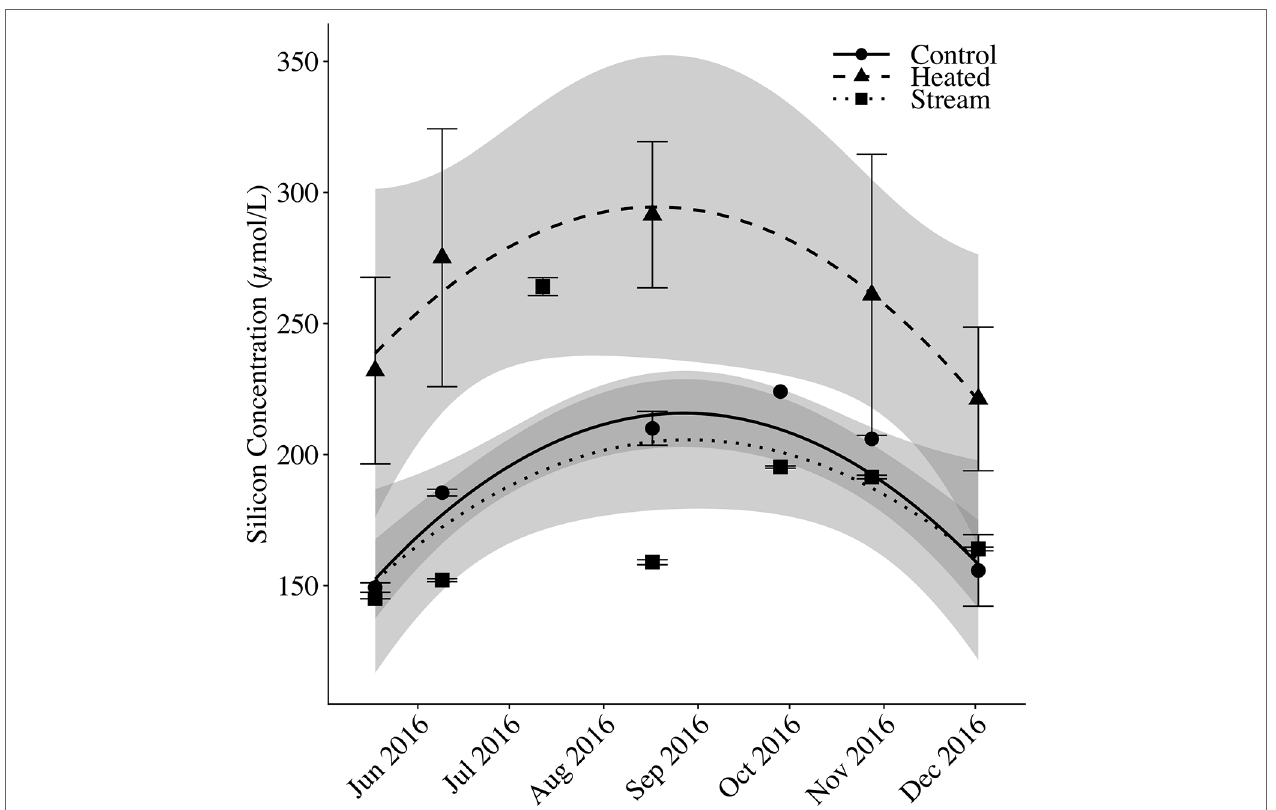
FIGURE 6 | Soil solution and streamwater silicon over time. Mean silicon concentrations (μmol Si/L) are shown for control plot soil solution, heated plot soil solution, and stream water. For soil solution, silicon concentrations are measured as dissolved silica (DSi) only. For stream water, silicon concentration was measured as DSi plus suspended BSi to account for in-stream biological Si uptake. Error bars represent standard error of the mean. Fitted lines with shaded error bounds are second-degree polynomial regression models and 95% confidence